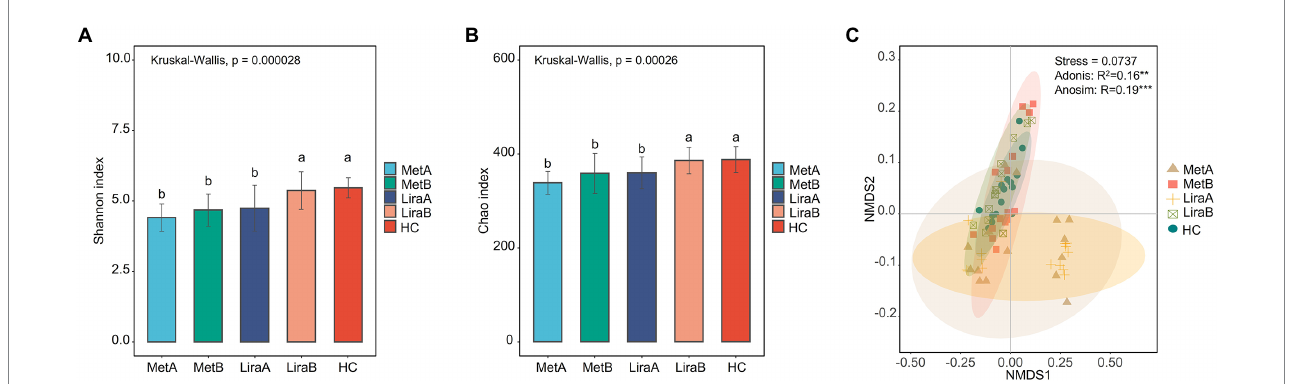
FIGURE 1 (A) Difference in the Shannon diversity index of the intestinal bacterial community between healthy controls and patients before and after metformin or liraglutide treatment. (B) Difference in the Chao richness index of the intestinal bacterial community between healthy controls and patients before and after metformin or liraglutide treatment. (C) β -diversity of the intestinal bacterial community in healthy controls and patients before and after metformin or liraglutide treatment. Different letters indicate significant differences between groups. p value < 0.05 indicates that the differences are significant. “**” and “***” indicate significant differences at the levels of 0.01 and